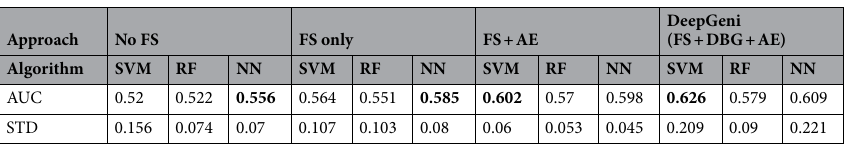
Table 2. Averaged AUC in cross-study validation setting. The bolded values indicate the best performance for each approach. FS feature selection, AE autoencoder, DBG DeepBioGen.